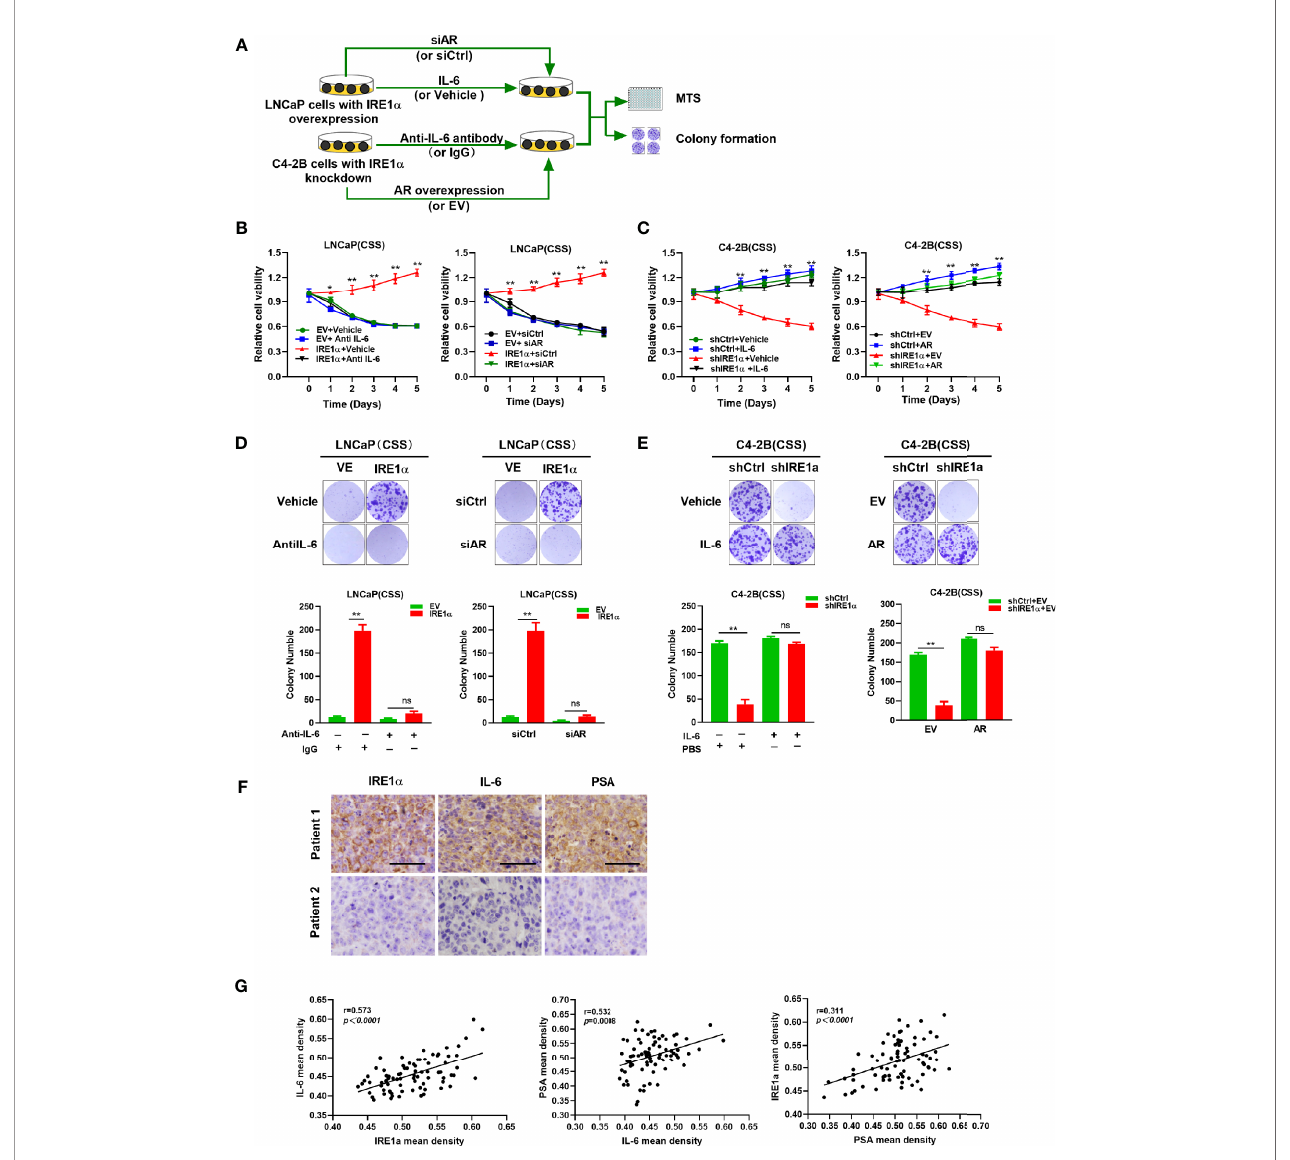
FIGURE 7 | IRE1 a promotes castration-resistant growth of prostate cancer cells in an IL-6/AR-mediated manner. (A) LNCaP cells with IRE1 a overexpression were treated with anti-IL-6 antibodies or transiently transfected with AR siRNA, and C4-2B cells with IRE1 a knockdown were treated with anti-IL-6 antibodies or transiently transfected with AR expression vector. MTS assay and colony formation assay were used to detect the effect of IL-6 or AR on IRE1 a -induced proliferation of prostate cancer cells. (B, D) MTS assay and colony formation assay of LNCaP cells with IRE1 a overexpression, which were treated with anti-IL-6 or transiently transfected with control siRNA or AR siRNA. (C, E) MTS assay and colony formation assay of C4-2B cells with IRE1 a knockdown, which were treated with IL-6 or transiently transfected with AR expression vector (AR) and empty vector (EV). (F) Representative prostate cancer samples showing the expression of IRE1 a , PSA and IL-6; patient 1, IRE1 a high; patient 2, IRE1 a low. Scale bar, 200 m m. (G) Scatter plot analysis revealed that protein levels of IRE1 a , PSA and IL-6 in prostate cancer tissues. Data shown are the mean ± SD from three independent experiments, **P < 0.01; ns, no signi fi